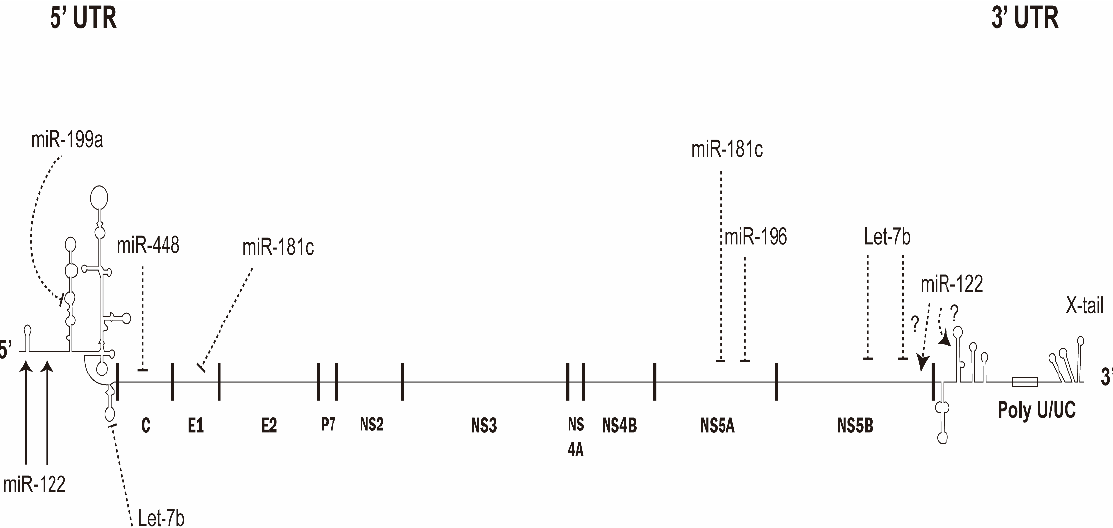
Figure 2. Target sites of various microRNAs on HCV genomic RNA. The 5 ′ UTR of HCV genomic RNA contains the target sites for miR-122, miR-199a* and let-7b; core gene for miR-448; E1 for miR-181c; NS5A for miR-181c and miR-196; and NS5B for let-7b. After binding to the target sites of HCV genomic RNA, several miRNAs such as miR-196, miR-448, miR-199a, let-7b and miR-181c suppress while miR-122 facilitates HCV genome replication and/or translation.